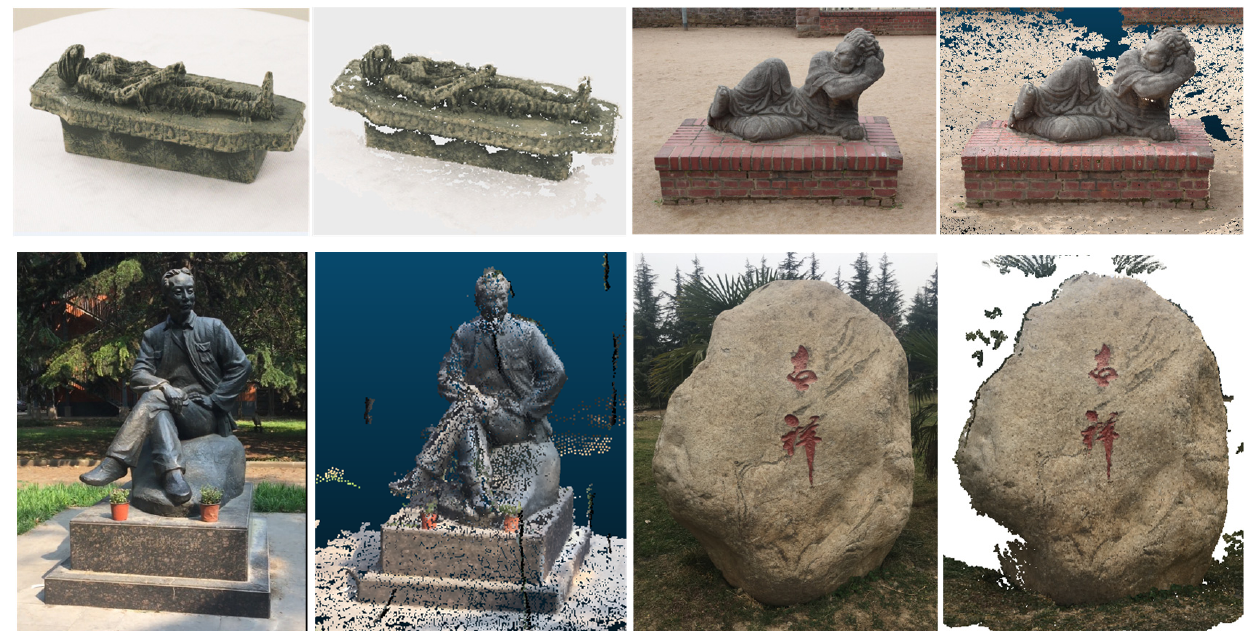
Figure 5. Results of proposed algorithm on other four datasets. Top: “Mummy24” and “Sclupture58”. Bottom: “Statue70” and “Stone39”. Left: sample of image sequence. Right: retrieved point